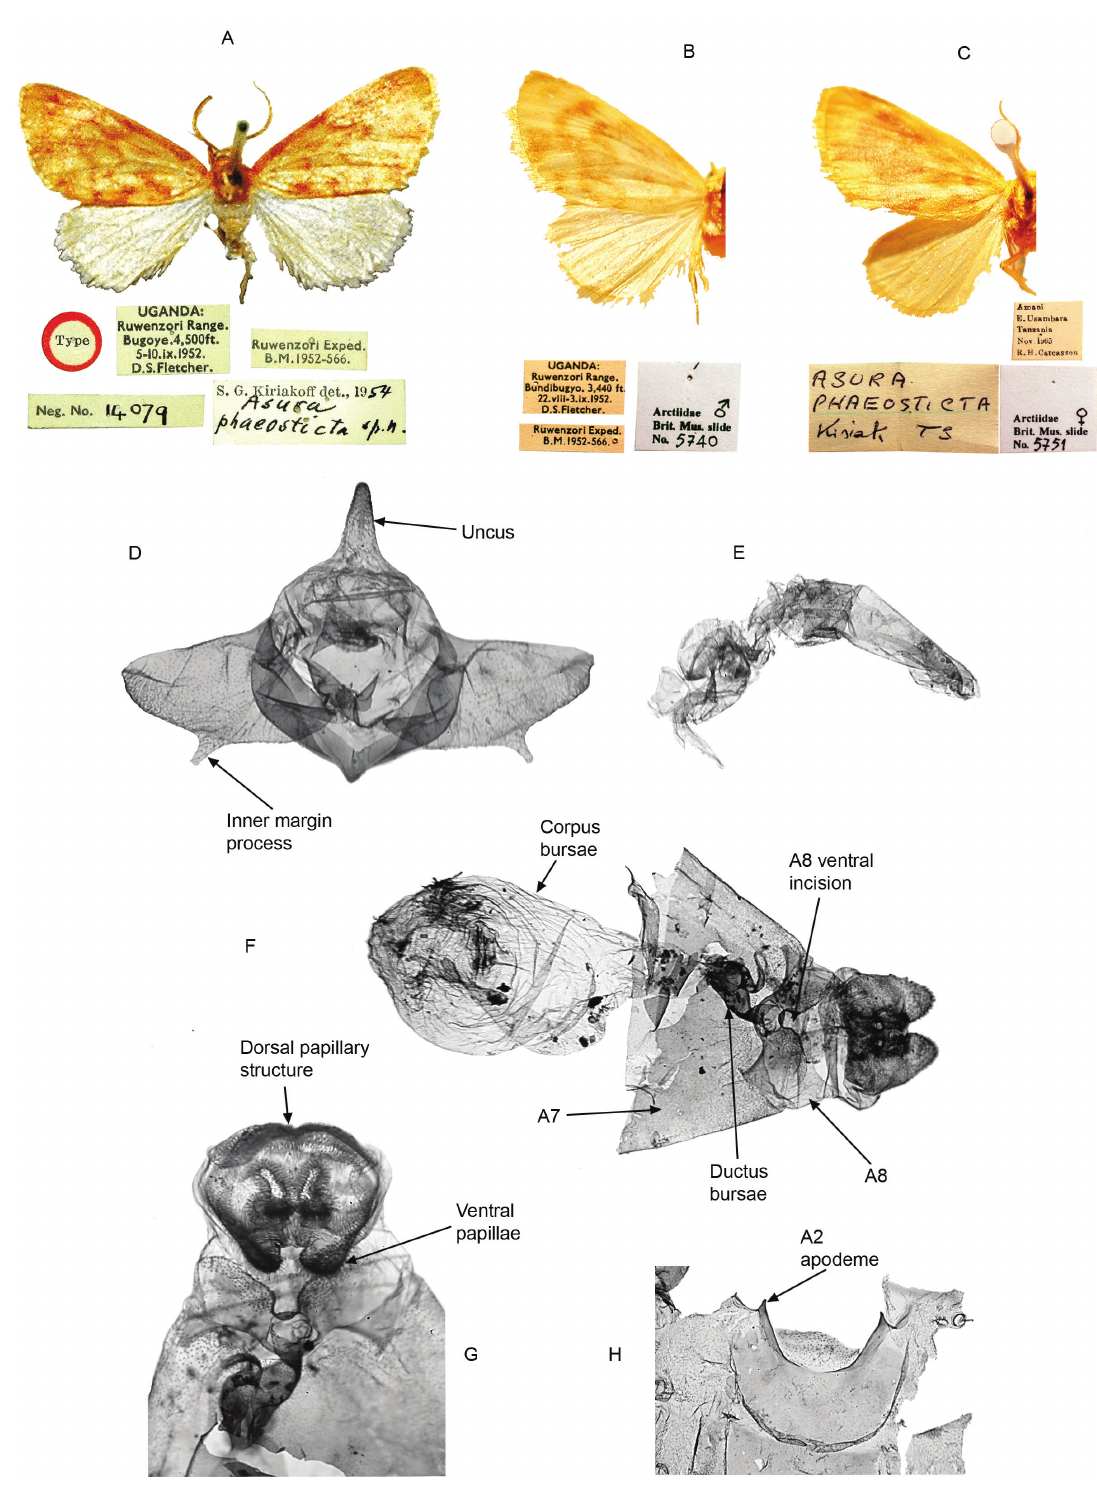
Fig. 7. Euproctis phaeosticta (Kiriakoff, 1958) comb. nov. A . Holotype ♂, Uganda, in BMNH. B . ♂, Uganda, in BMNH. C . ♀, Tanzania, in BMNH. D . ♂ genitalia, g.sl. BM ARCT 5740, Uganda. E . Aedeagus, g.sl. BM ARCT 5740, Uganda. F . ♀ genitalia, g.sl. BM ARCT 5751, Tanzania. G . ♀, ventro-caudal view of papillae anales, g.sl. BM ARCT 5751, Tanzania. H . ♂, sternum A2 apodemes, g.sl. BM ARCT 5740,